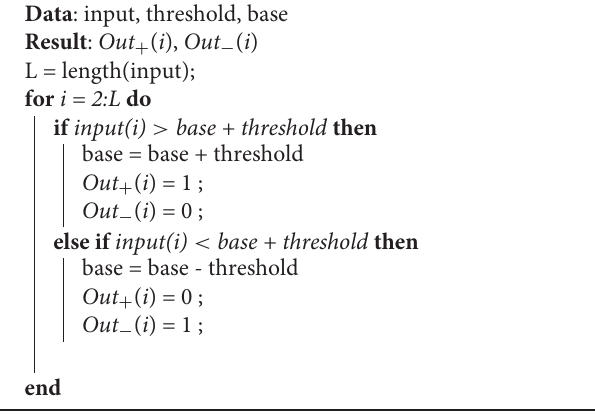
TABLE 4 | RMSE analysis result comparison for STDP-SNN, RSTDP-SNN, and PID controllers. Signal RSTDP STDP PID Position 0.101231 0.12089 0.116812 Velocity 0.116812 0.21960 0.33481 Acceleration 0.43922 0.400311